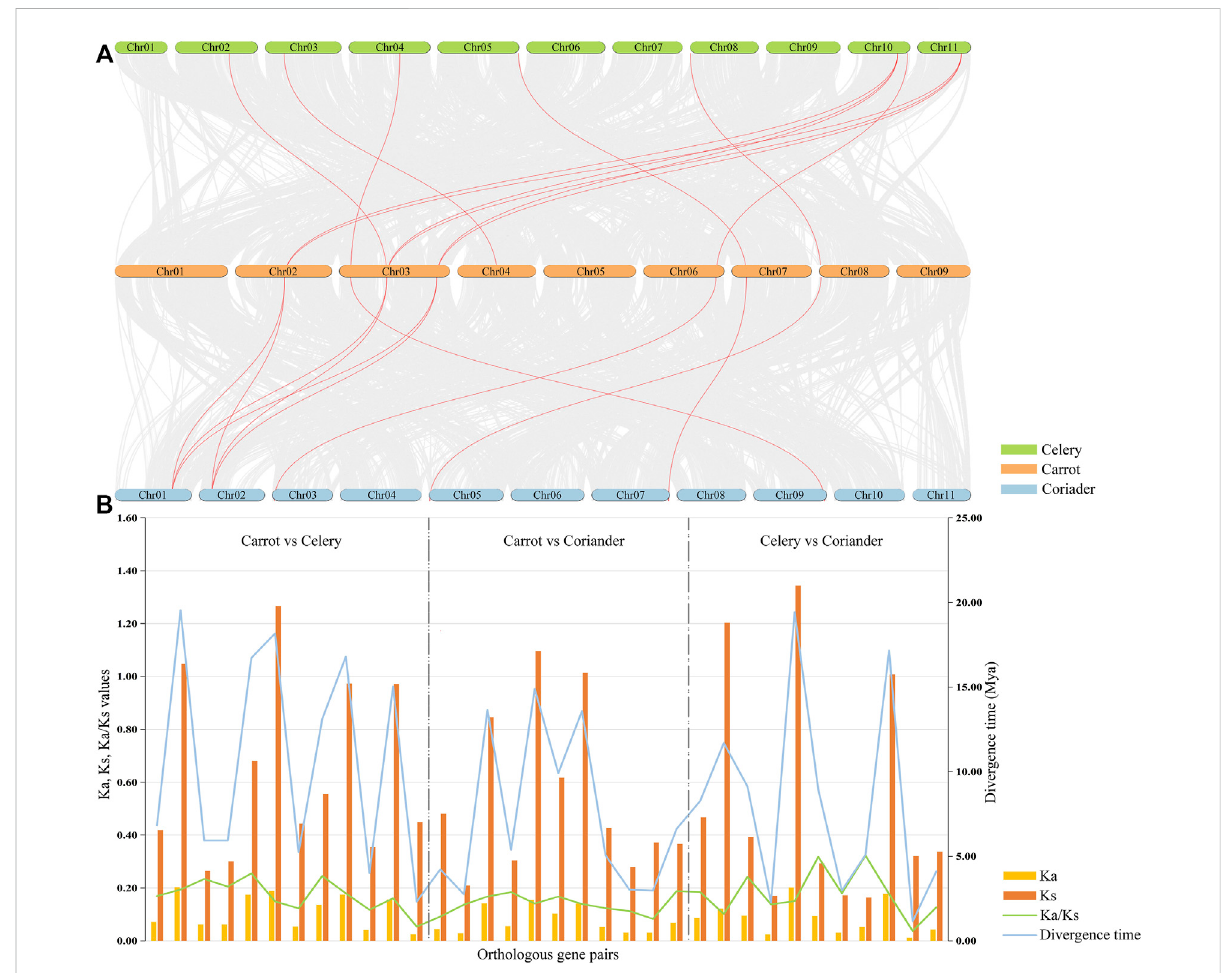
FIGURE 4 Collinearity analyses of PEBP genes among three Apiaceae species. Red lines indicate the intergenomic collinearity (A) . Ka/Ks ratios and divergence time of orthologous PEBP gene pairs were estimated between any two of carrot, celery and coriander (B)